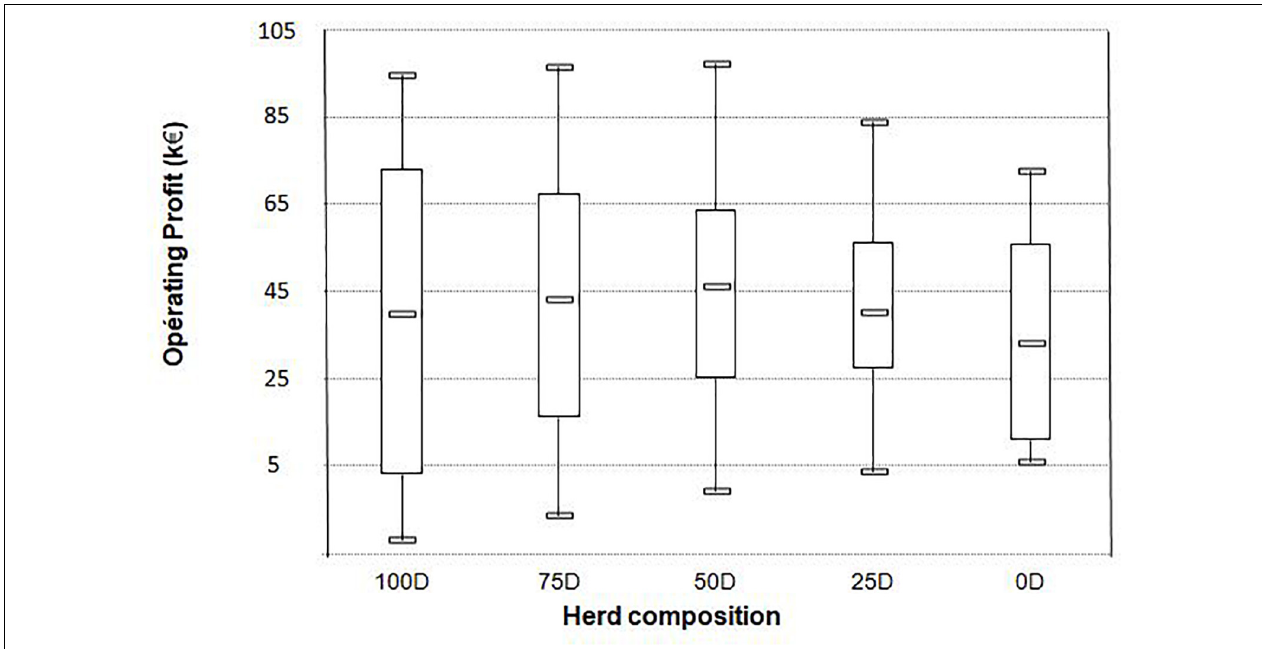
FIGURE 5 | Boxplots of net profit from 27 simulations in scenarios of a mixed dairy-beef farm in French Massif central, in which prices of milk, beef, and concentrate feed varied simultaneously among three levels [adapted from Diakité et al. (2019)]. D represents the relative proportions of dairy cows, so that 75D is a 75–25%